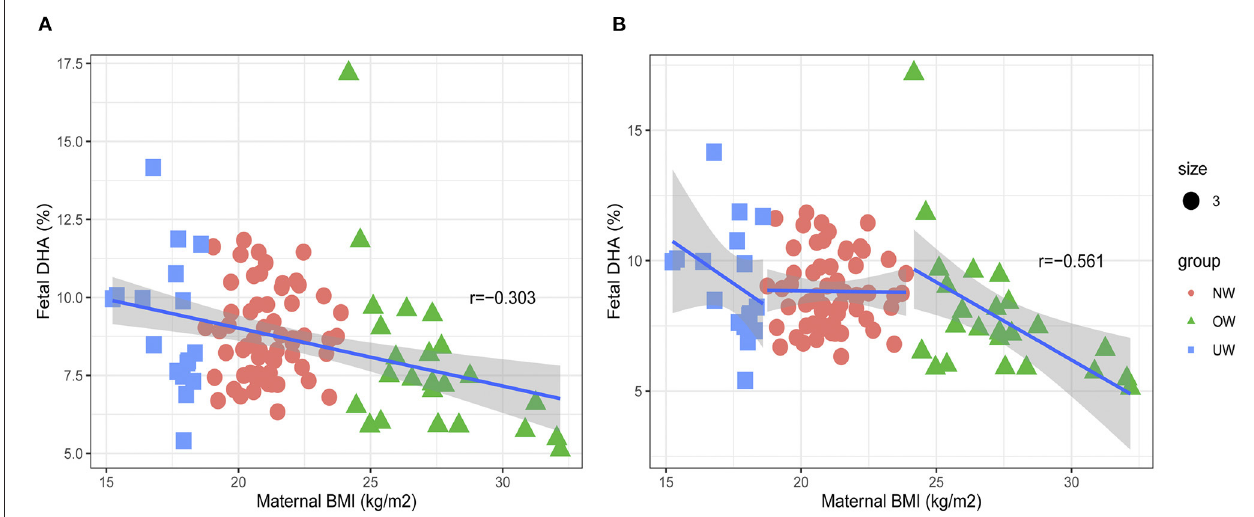
FIGURE 2 | Associations between maternal pre-BMI and fetal DHA. (A) The association between maternal pre-BMI and fetal DHA in all subjects. (B) The association between maternal pre-BMI and fetal DHA in different groups.